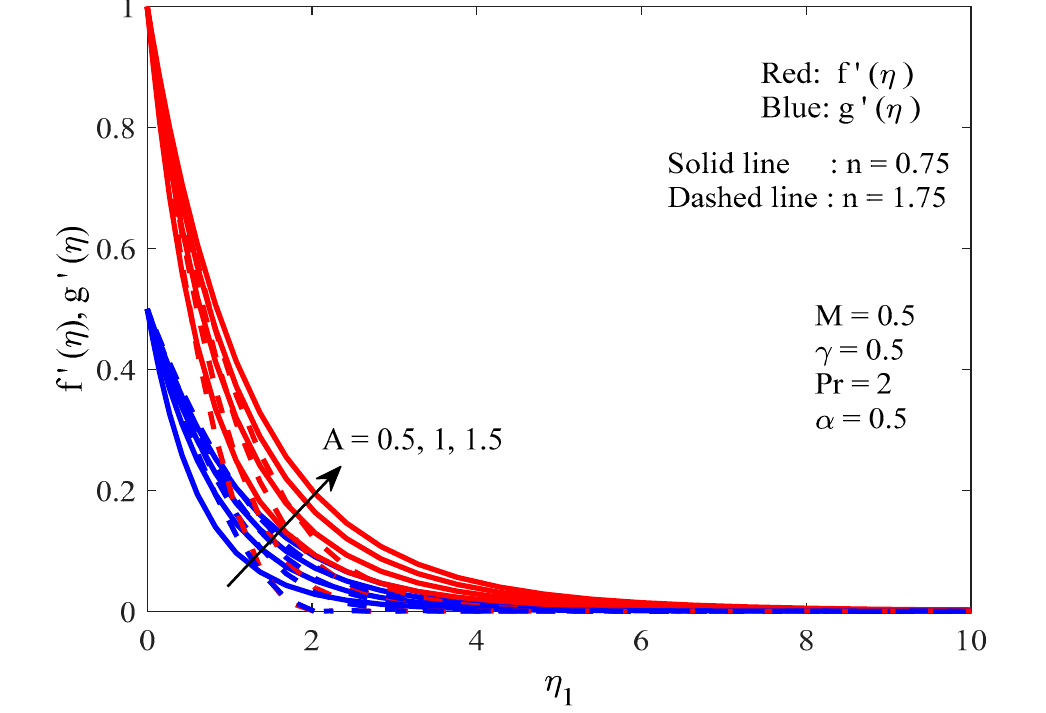
Figure 6. The bidirectional (axial and transverse) velocity distribution profiles with the influence of A .